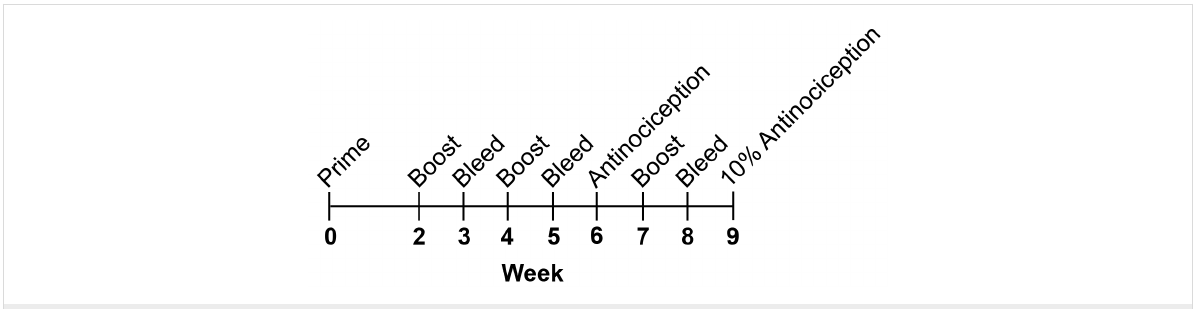
Figure 4: Vaccination, titer assessment, and bleed schedule.